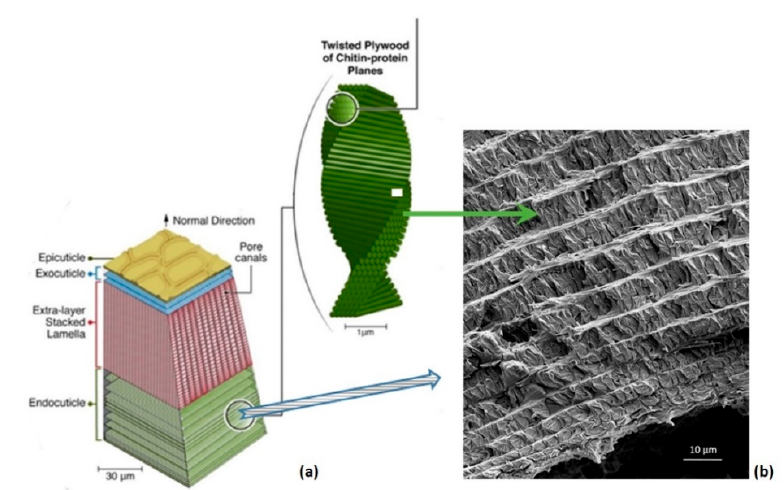
Figure 3. ( a ) General view of the Scorpio maurus palmatus (SP); ( b ) Detail of the tibia (chela); ( c ) SEM view of the cross-section revealing the layered structure of the endocuticle.